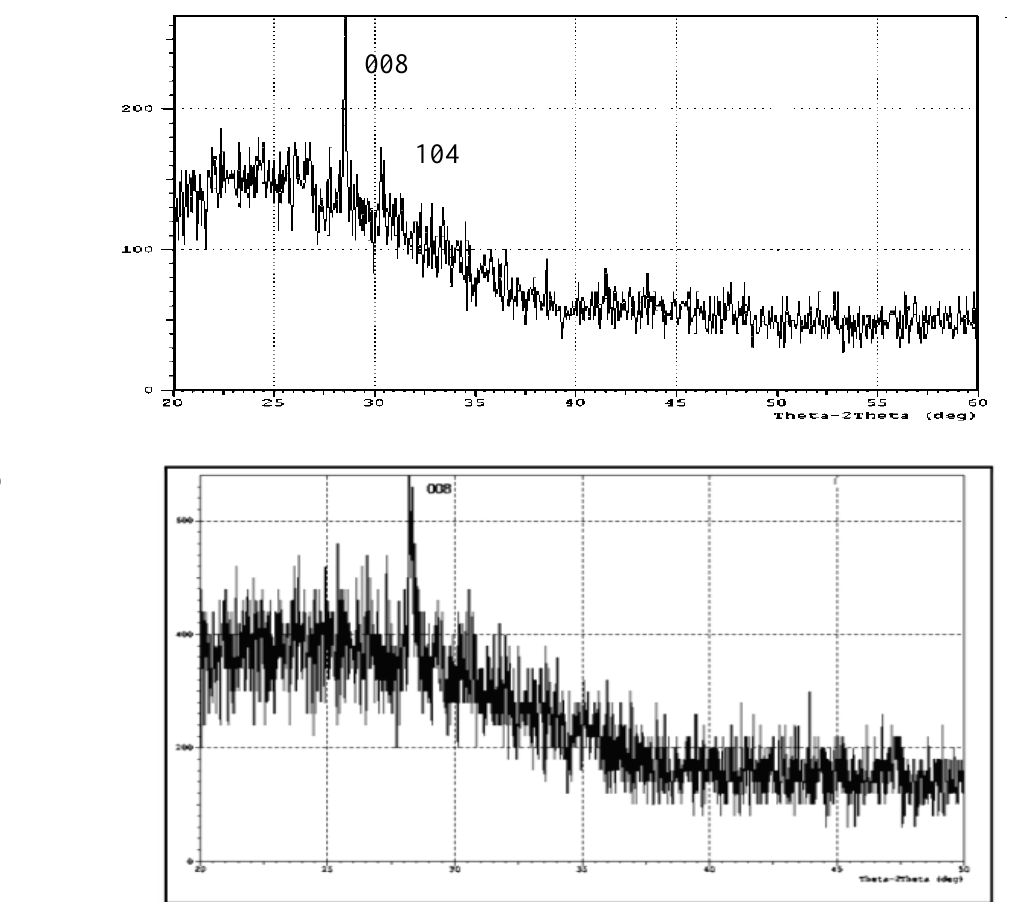
Fig.6: XRD diffraction pattern of ZnS a) at laser energy 1000mJ and b) at laser energy 700mJ.